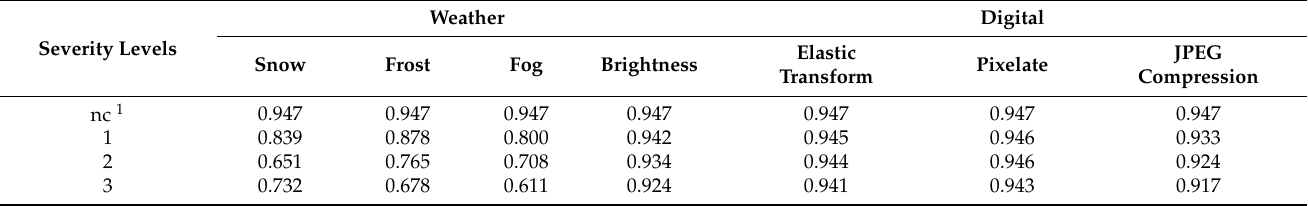
Table 8. Average precision for different weather conditions and digital processing at three severity levels obtained by ATSS.